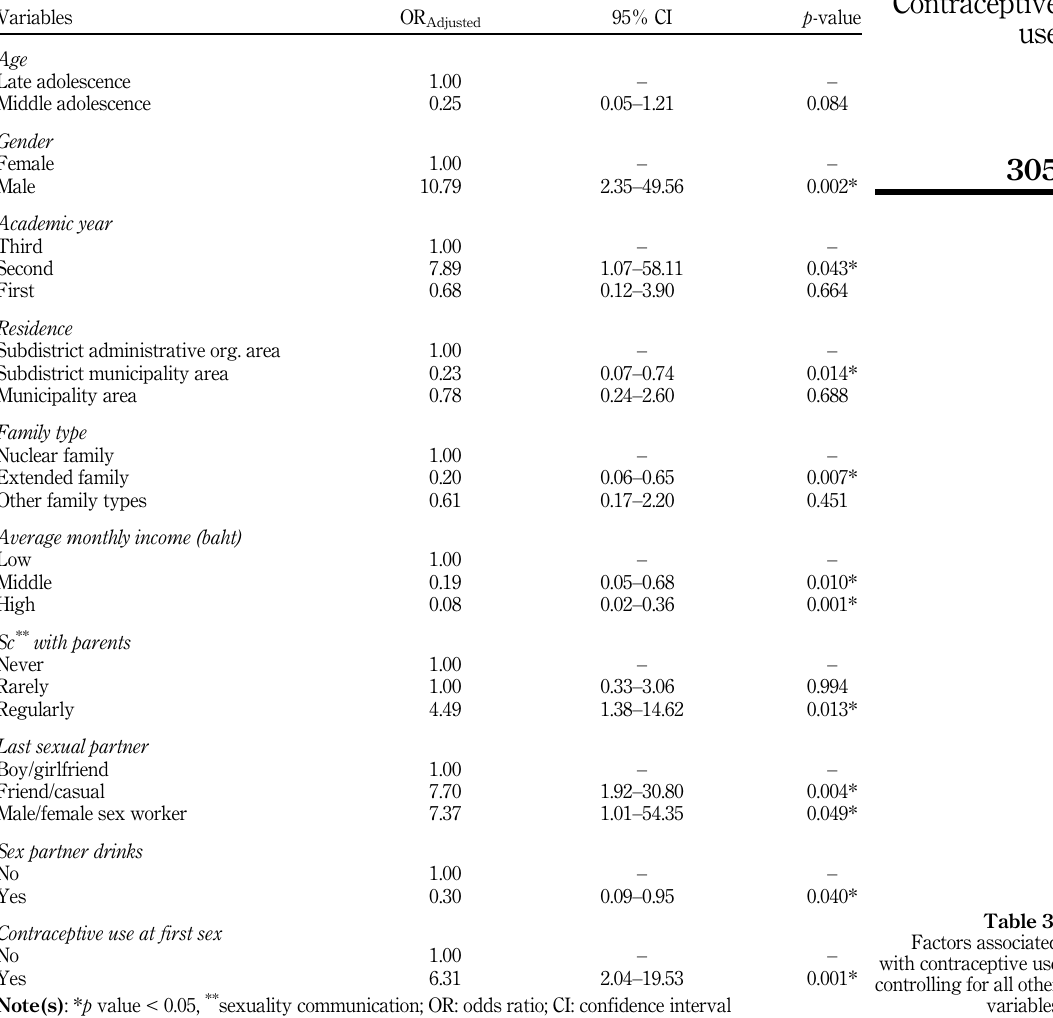
Table 3. Factors